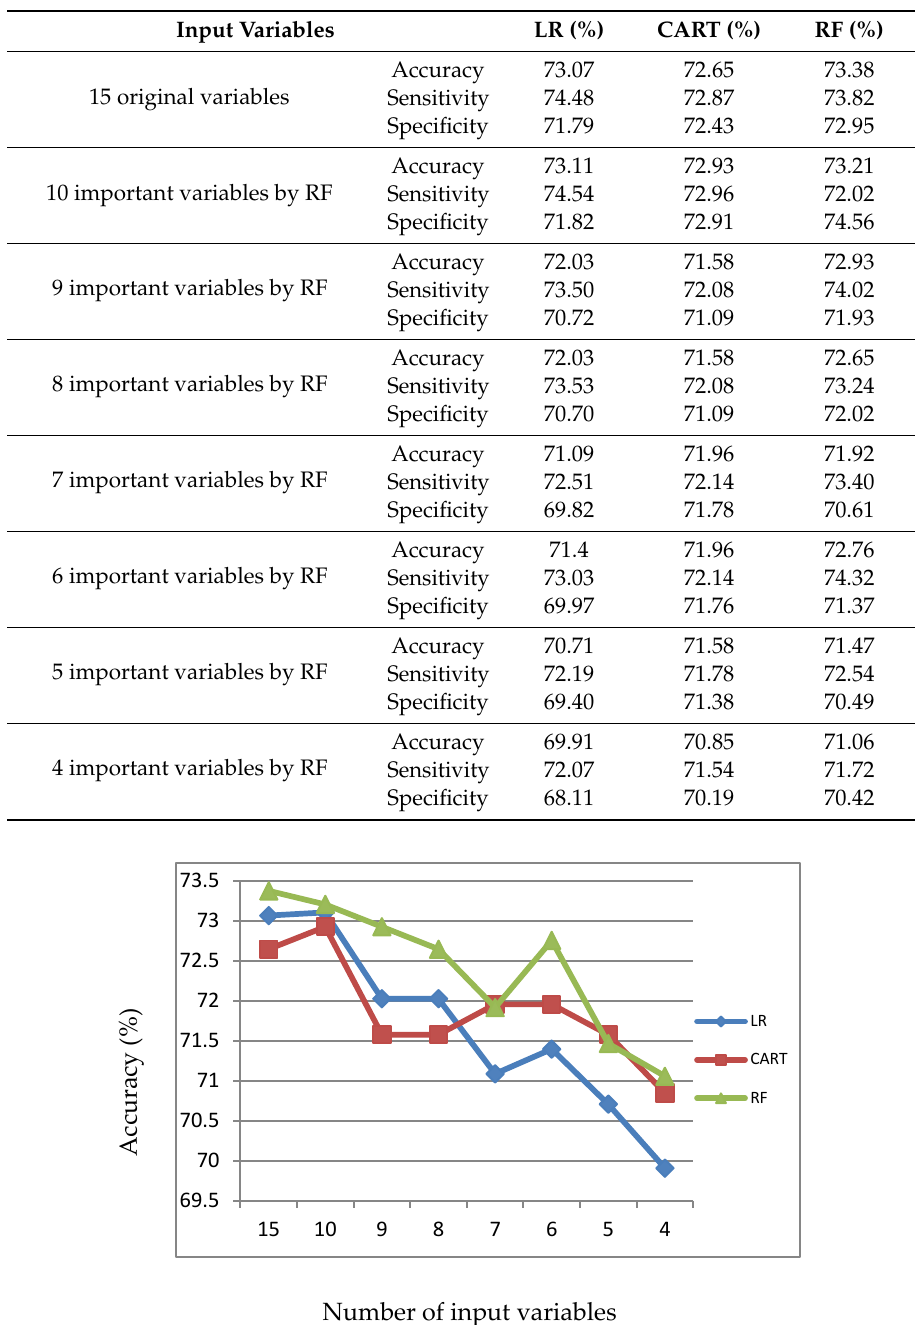
Table 7. Accuracy, sensitivity and specificity of LR, CART and RF with input of important variables identified by RF.